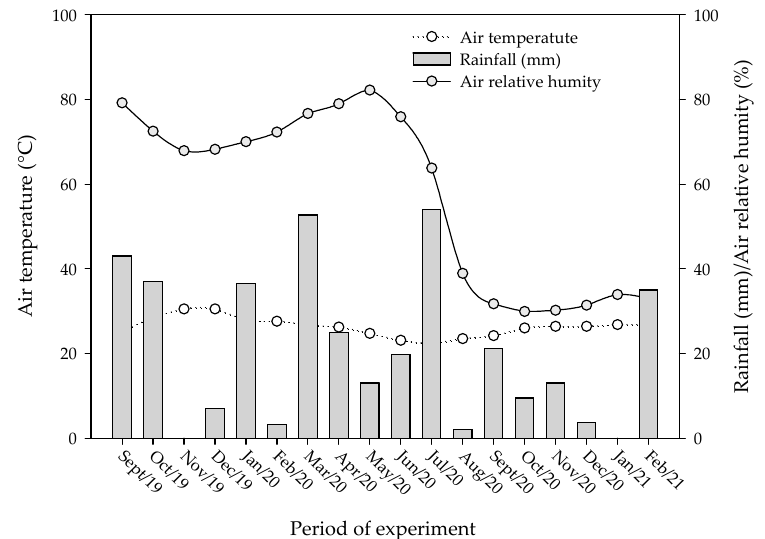
Figure 6. Meteorological data—temperature, relative humidity of the air, and rainfall collected at the experimental site during the study period.